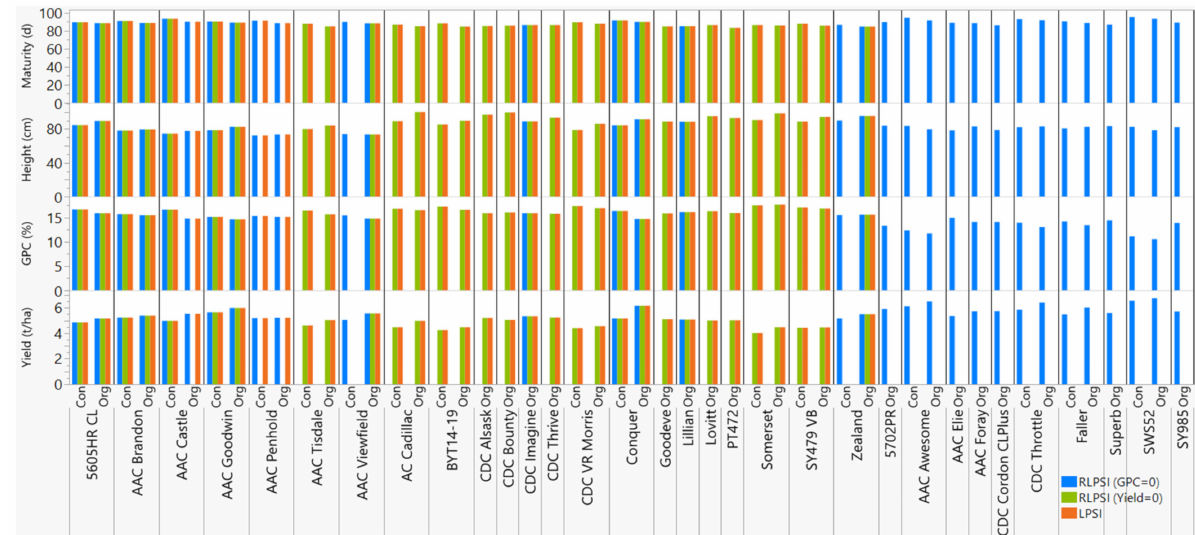
Figure 4. Comparison of the phenotypic performance of 32 cultivars consistently selected for their superior performance under organic management system using all five economic weights and the Smith Linear Phenotypic Selection Index (LPSI) and Kempthorne and Nordskog Restrictive Linear Phenotypic Selection Index (RLPSI). The RLPSI analyses were done by restricting the expected genetic gain either for yield (Yield = 0) or grain protein content (GPC = 0). The y-axes represent the best linear unbiased estimators computed from the conventionally or organically managed environments. See Table S1 for